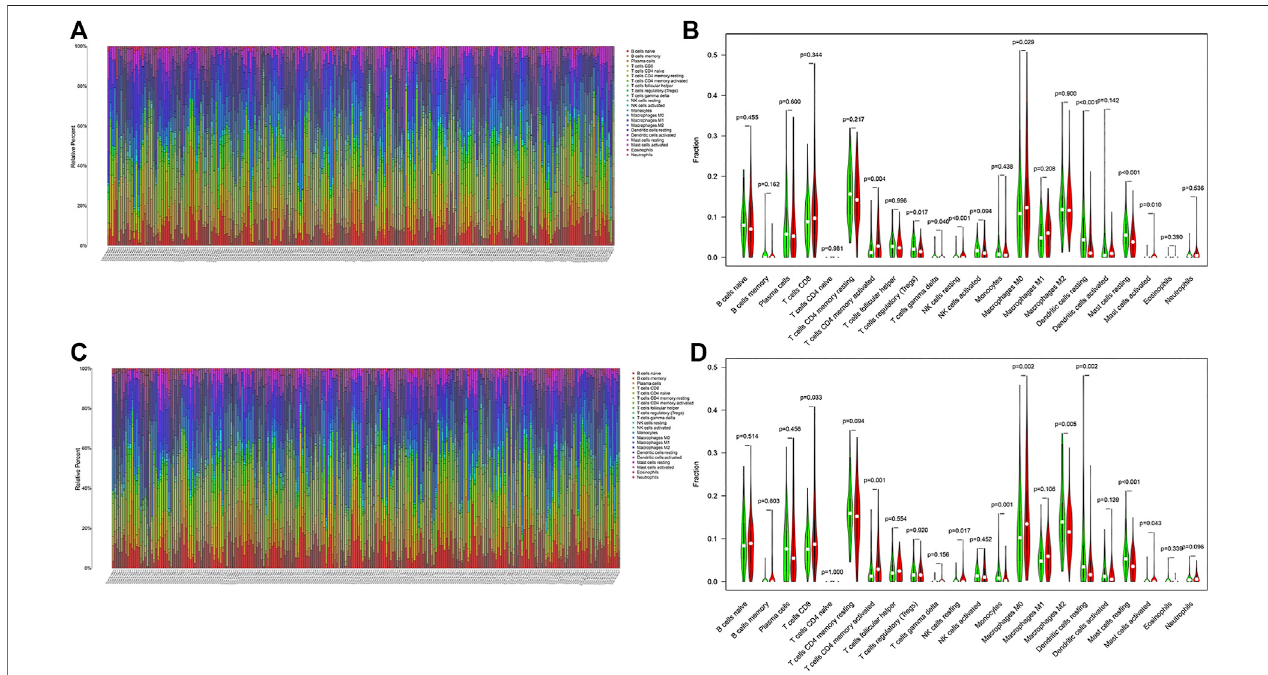
FIGURE8| Landscapeofimmunecellin fi ltrationinLUAD.Immune landscapeofthepatientswithLUAD (A) inthetrainingand (C) validation cohorts.Relationships between the risk score and immune cell in fi ltration (B) in the training and (D) validation cohorts. Red and green represent the high- and low-risk groups, respectively.